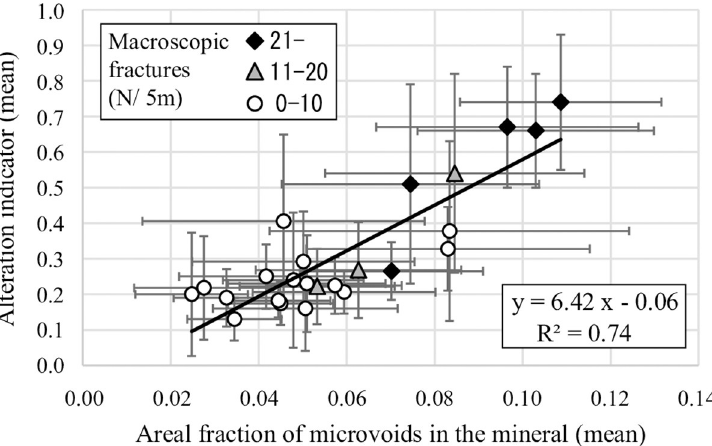
Fig 8. Relationship between the areal fractions of microvoids in the chloritized biotites (mean values for rock samples) and the corresponding alteration indicators (N = 24). Black diamond symbols denote samples with macroscopic fracture frequencies exceeding 21 fractures per 5 m. Grey triangle symbols are samples ranging from 11 to 20 fractures per 5 m in macroscopic fracture frequency, and open circle symbols indicate samples with macroscopic fracture frequencies below 10 fractures per 5